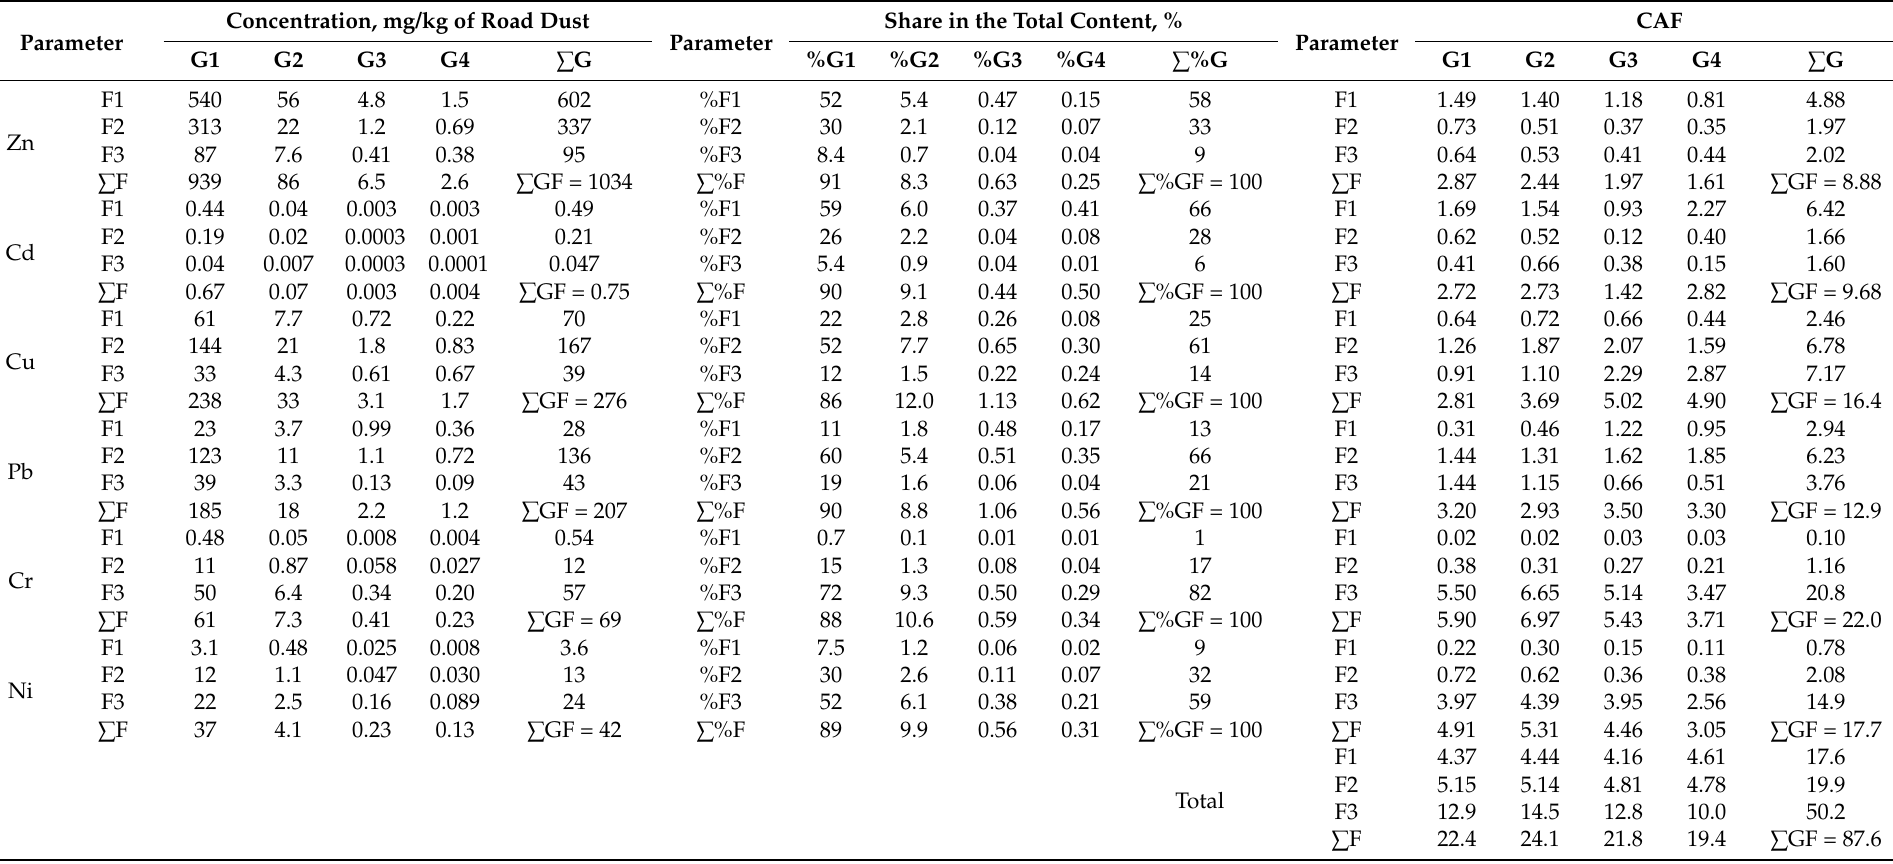
Table 4. Results of chemical and grain size fractionation of HMs (GF-analysis) in road dust from Benowa suburbs, Gold Coast, South East Queensland, Australia, and levels of CAF —calculated from the data of A. Jayarathne et al. [100].